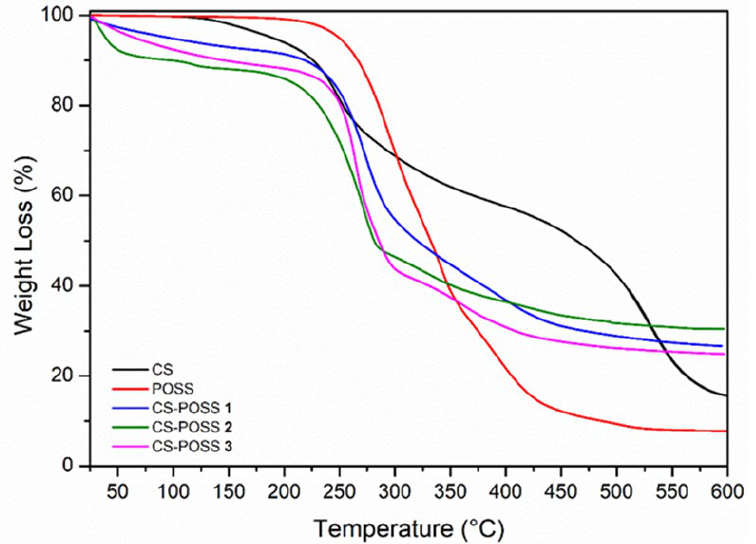
Figure 3. TGA curves for CS-, POSS-, and CS-POSS-based samples, CS-POSS 1 , CS-POSS 2 , and CS-POSS 3 . All experiments were performed in triplicate under argon atmosphere.